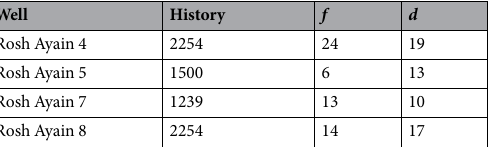
Table 4. Optimal historical window length (History); number of hidden layers ( f ); and delay ( d ) for classification between normal and high-risk states.